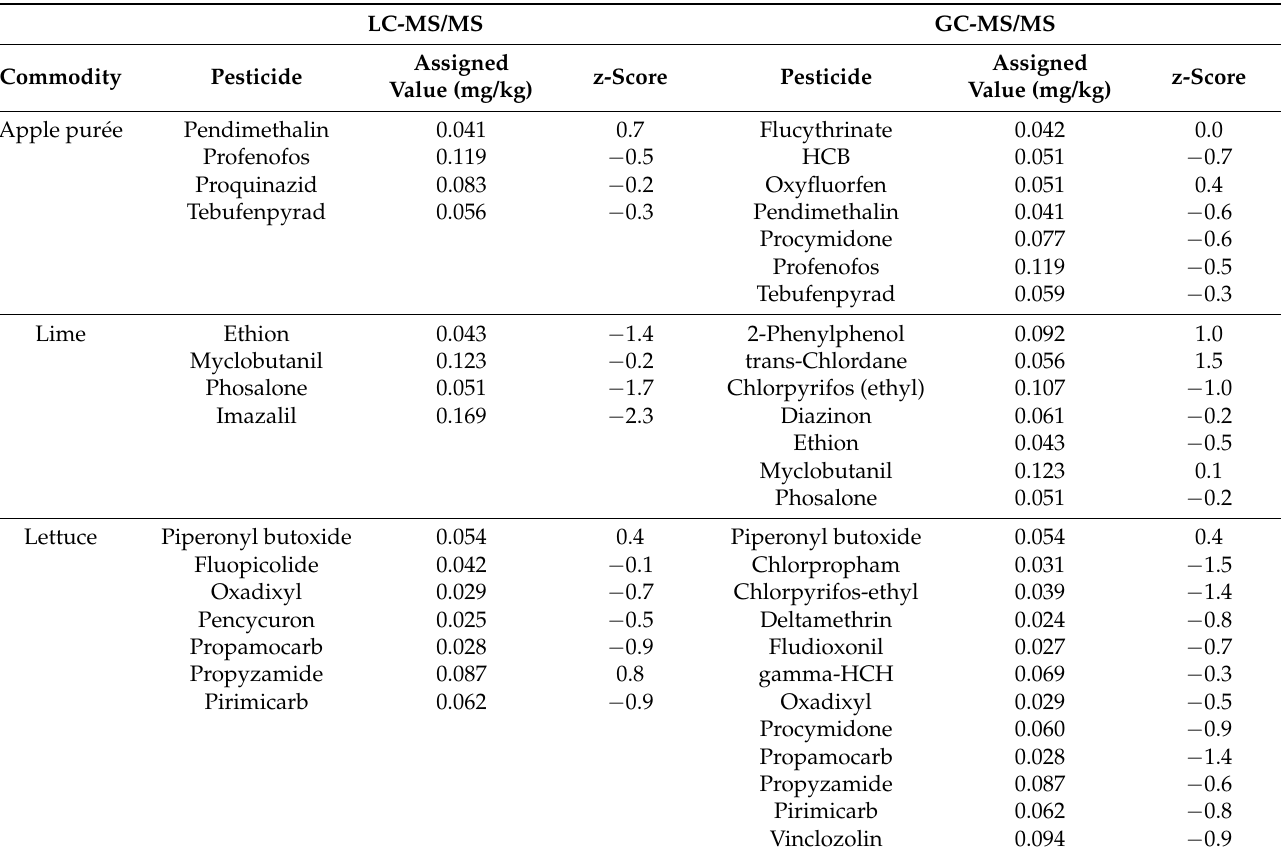
Table 5. Proficiency testing schemes results.